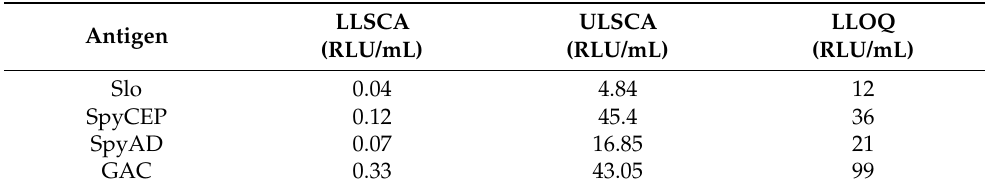
Table 1. Standard curve performance characteristics. Limits of standard curve accuracy and lower limit of quantification to measure IgG to four vaccine antigens were calculated from 12 independent assays. LLSCA = Lower limit of standard curve accuracy, ULSCA = Upper limit of standard curve accuracy. LLOQ = Lower limit of quantification.